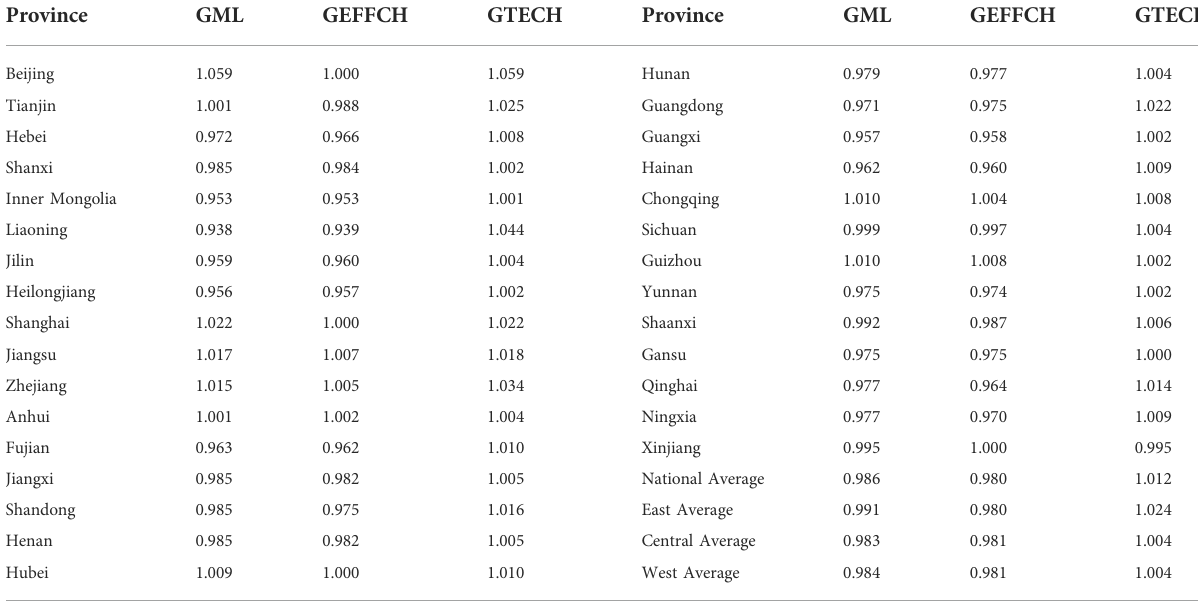
TABLE 3 GTFP index (GML) and its decomposed indicators for 30 Chinese